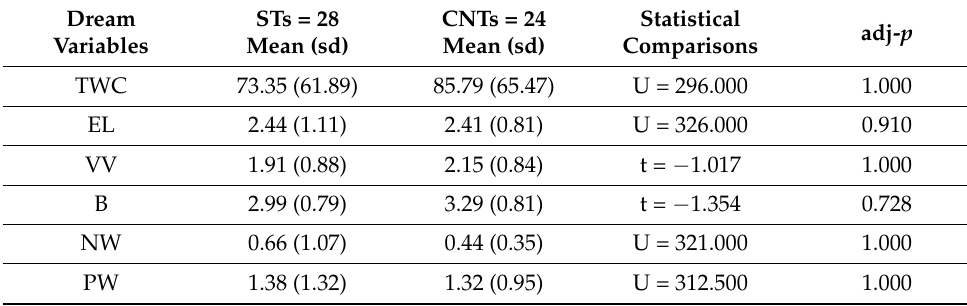
Table 3. Comparison results of dream variables between STs and CNTs.